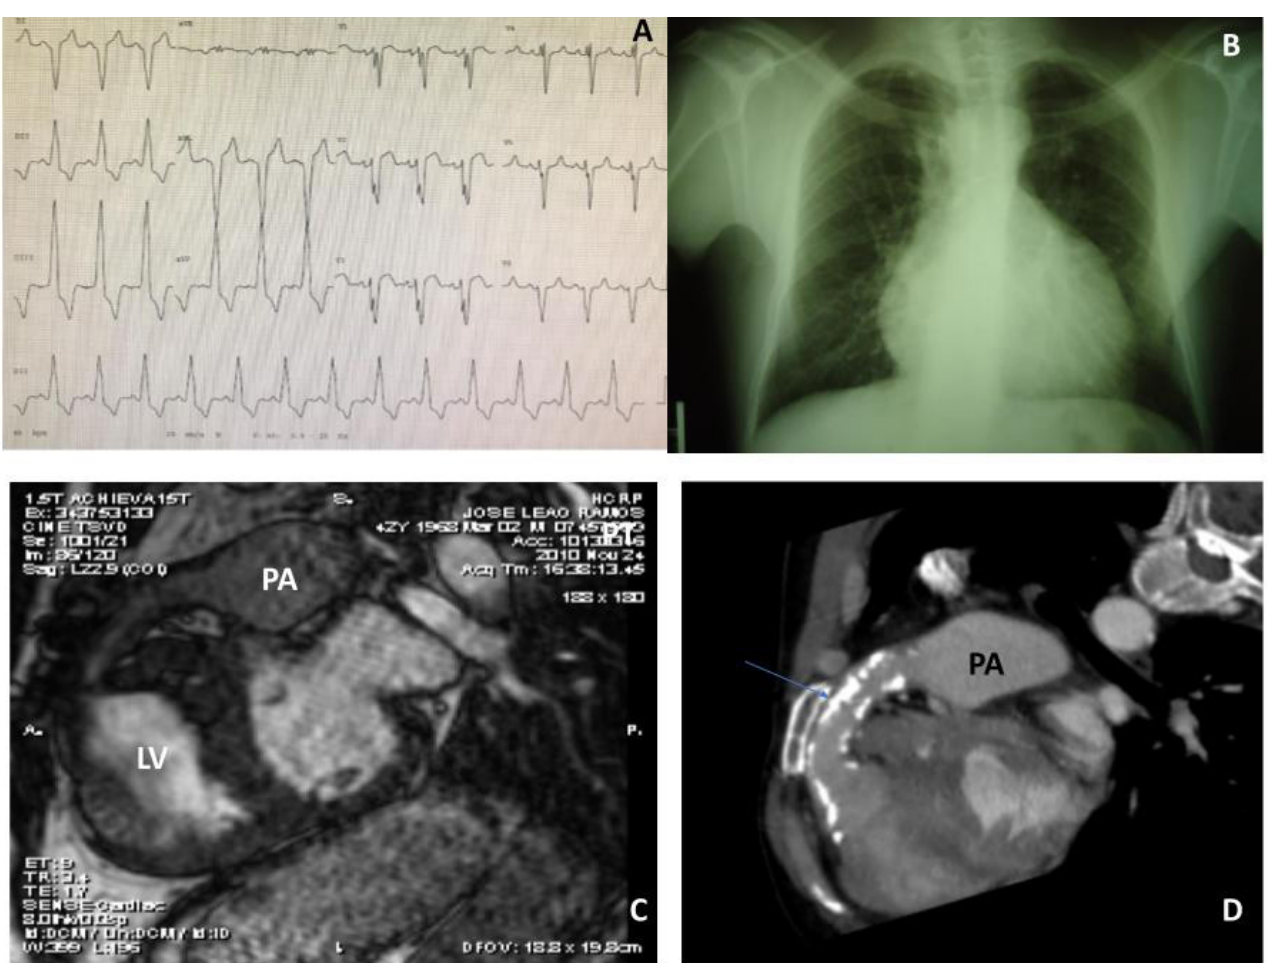
Fig. 6 - Preoperative electrocardiogram (A), chest radiography (B), magnetic resonance (C), and computed tomography (D) of a patient with congenitally corrected transposition of the great arteries who had a Rastelli operation at age 12 and died immediately after a homograft replacement for a severely calcified and stenotic valve (arrow) at age 40. LV=left ventricle; PA= pulmonary